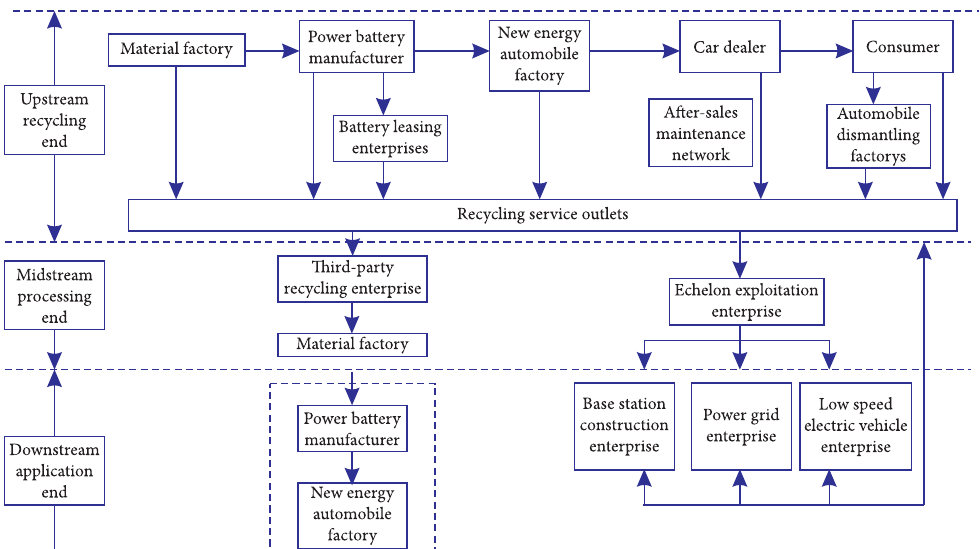
Figure 1. Power battery life